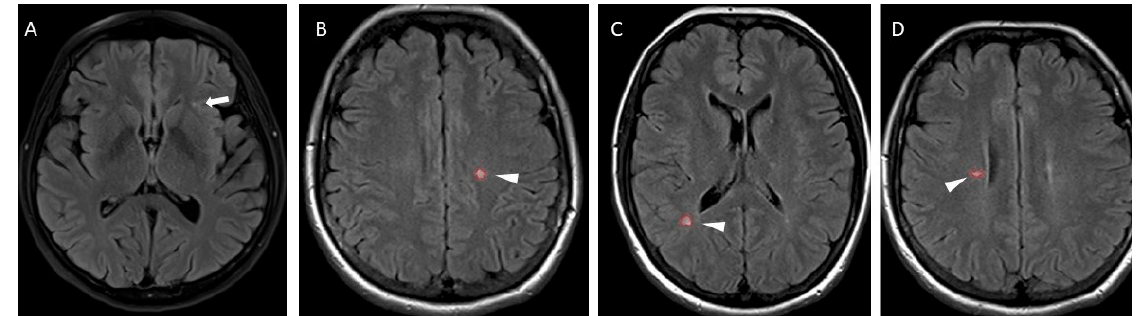
Figure 1. MRI images of multiple sclerosis (MS) and nonspecific white matter lesion (NSWMLs) patients. ( A ) Axial fluid-attenuated inversion recovery (FLAIR) images of NSWMLs patients showing a subtle white matter lesion located in deep white matter (white arrow). ( B – D ) Axial FLAIR images with hyperintense lesions in typical locations for MS (arrowhead).